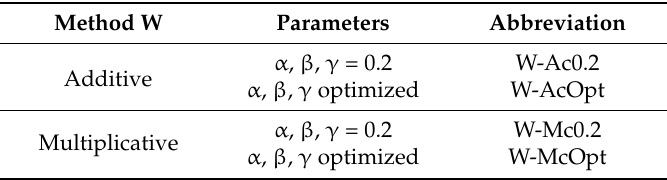
Table 2. Holt-Winters exponential smoothing model